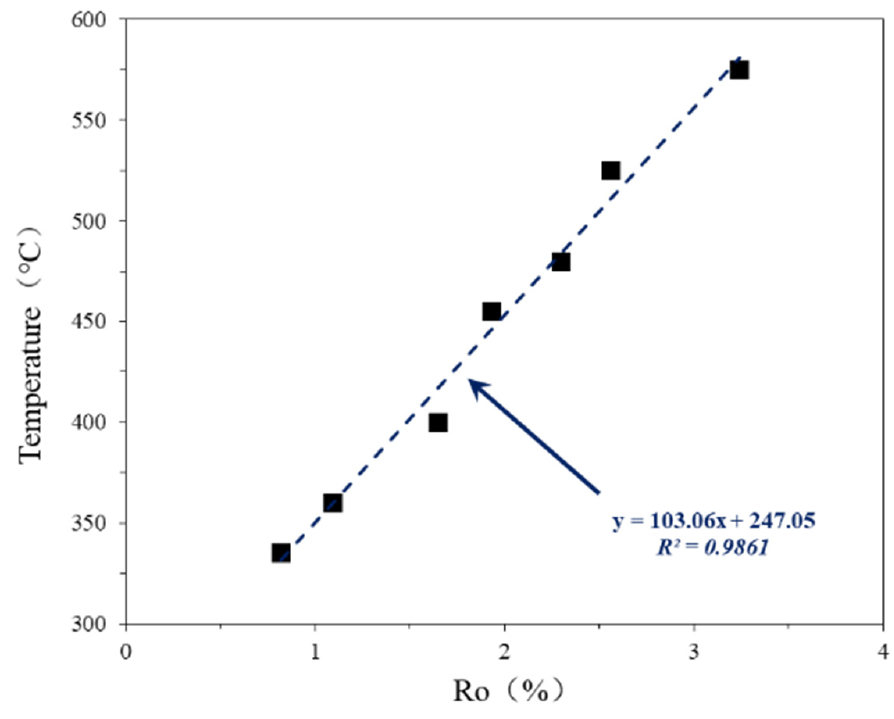
Figure 3. Correlation between the simulated temperature and measured Ro. The changing characteristics in gaseous hydrocarbons, expelled oil, and residual bitumen with increasing Ro are shown in Figure 4. With an increase in Ro, the gaseous hydrocarbon yield tended to increase gradually. When Ro equaled 0.82% to 1.09%, the yield of gaseous hydrocarbons increased slowly with a smaller change in amplitude. When Ro equaled 1.65% to 2.56%, the yield of gaseous hydrocarbons increased rapidly at a constantly increasing rate, which had a larger increase in amplitude. When Ro equaled 2.56% to 3.24%, the yield of gaseous hydrocarbons increased sharply with an increase in amplitude = 124.74%. Overall, the yield of expelled oil first reached a specific value and remained constant at the corresponding value. The yield of expelled oil at Ro equaled 0.82% to 1.09% and the corresponding simulated temperature (Ts) was 335–360 ◦ C, and increased rapidly from 19.36 to 46.76 mg/g TOC, with an increased amplitude of 141.53%. When Ro equaled 0.82% to 1.09% (Ts is 335–360 ◦ C), the high amplitude of expelled oil increased slowly from 46.76 to 50.16 mg/g TOC compared with the previous thermal evolution stage. At the stage where Ro > 1.65%, i.e., after the simulated temperature was higher than 40 ◦ C, the yield of expelled oil was 50.16, 50.07, 50.25, 50.18, and 50.22 mg/g TOC, respectively. Therefore, the yield of the expelled oil was